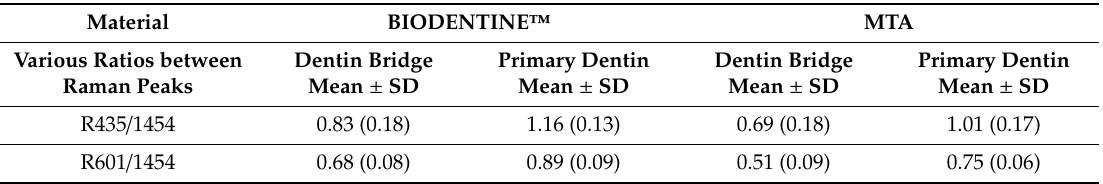
Figure 6. Representative Raman spectra of the dentin bridge (blue line) and primary dentin (red line) of the MTA group. The spectra were normalized based on the peak intensity of the CH 2 bending vibration at 1450 cm − 1 . Table 2. The Raman intensity ratios of various peaks to the peak of CH 2 at 1450 cm − 1 from the dentin bridge and primary dentin.